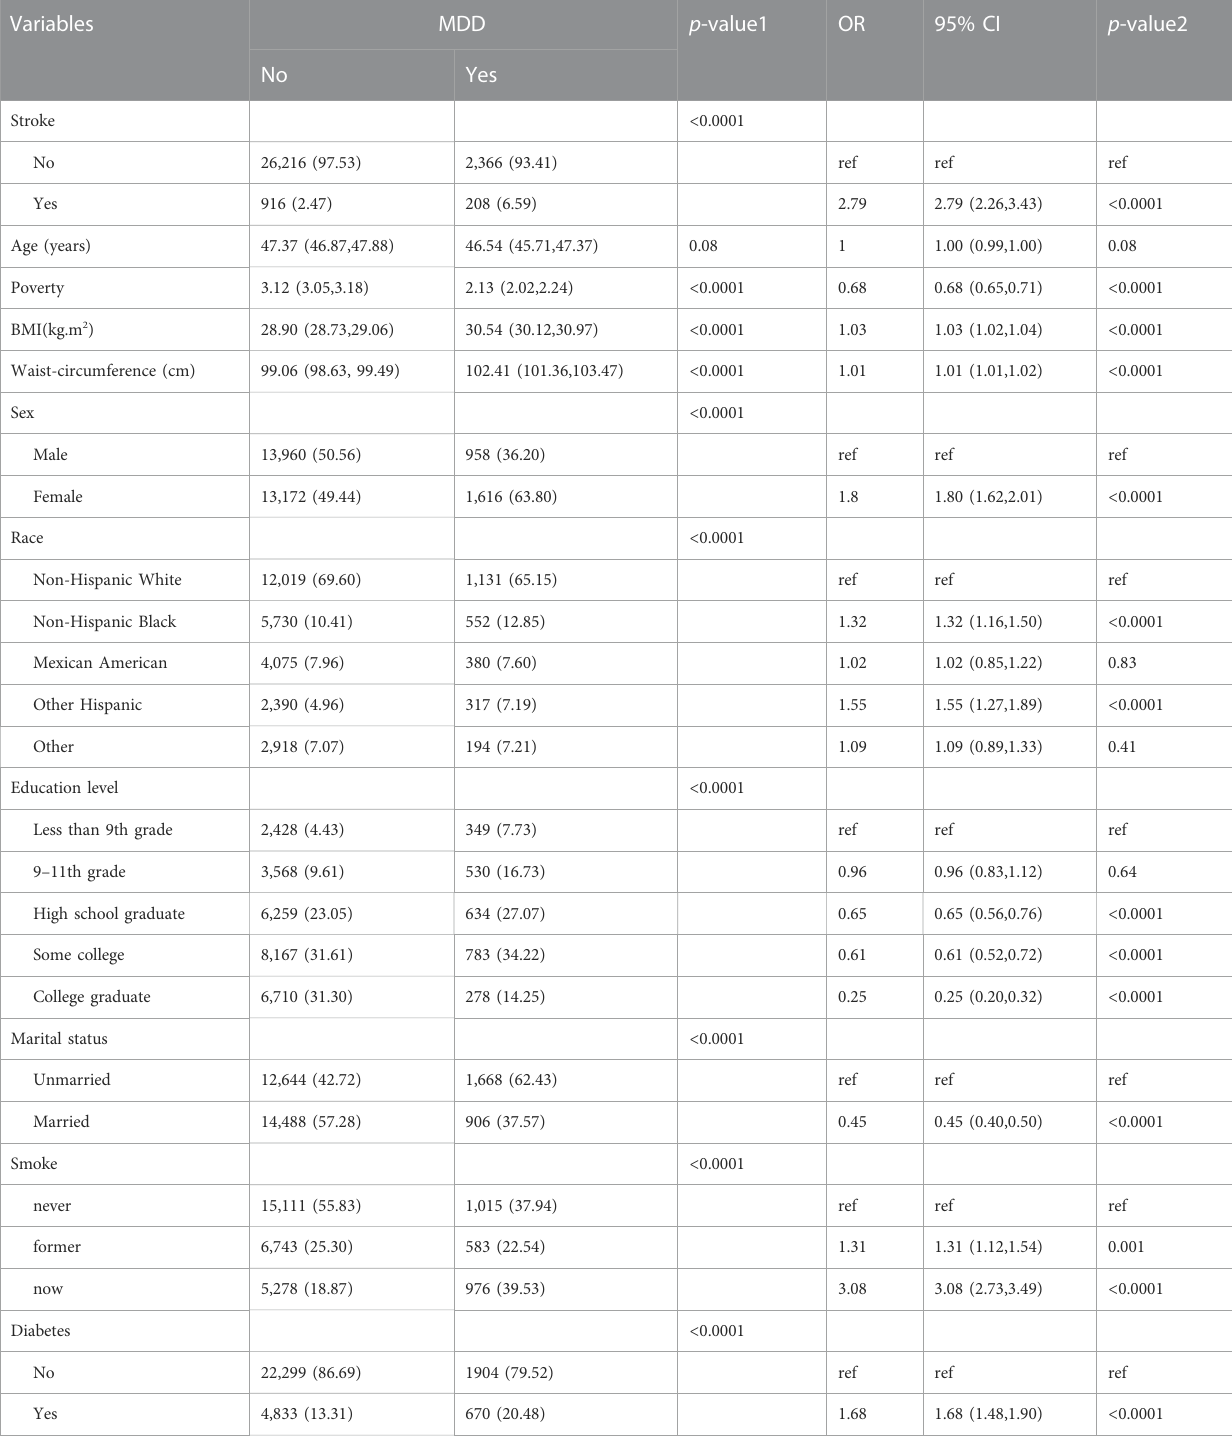
TABLE 2 Baseline characteristics and odds ratio of participants by MDD levels in NHANES (2005 – 2018). Variables MDD p -value1 OR p